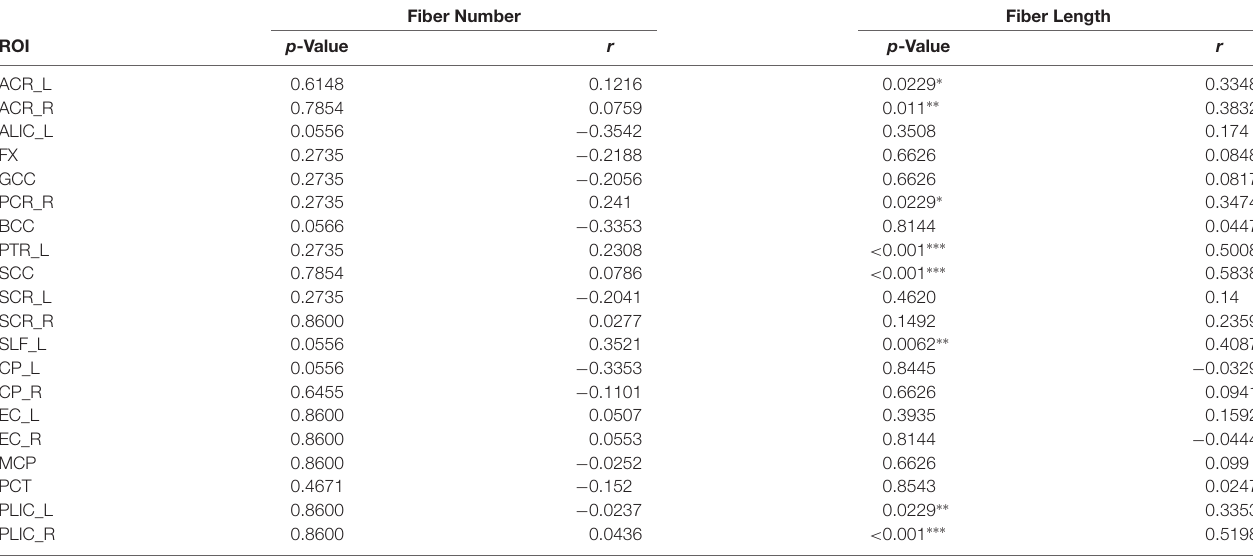
TABLE 3 | The deterministic fiber tracking results were obtained by age.